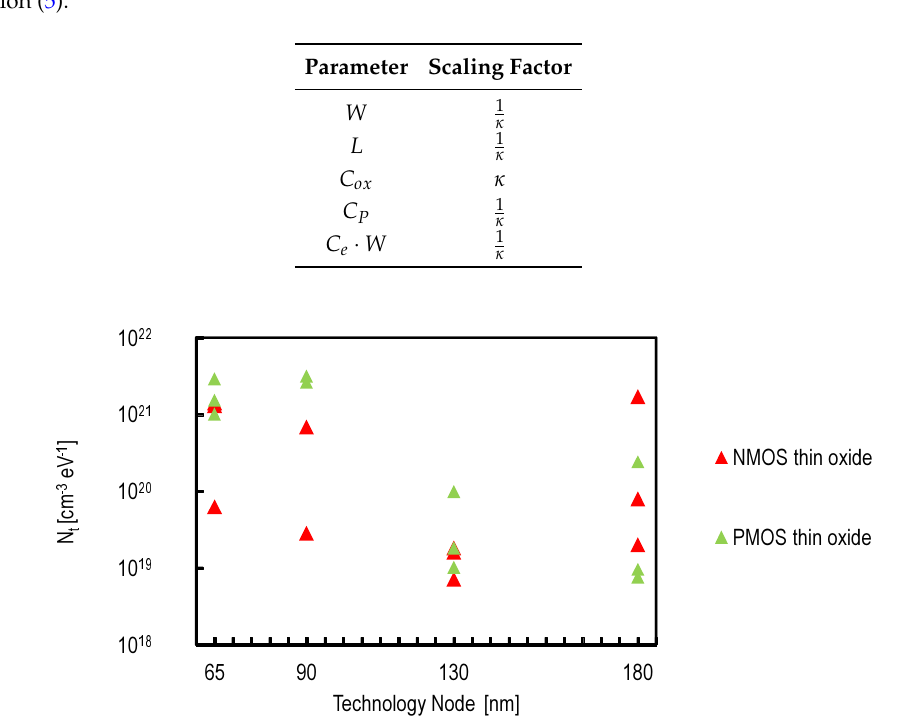
Table 1. Impact of technology downscaling on the parameters of the input-referred 1/ f noise in Equation (5).